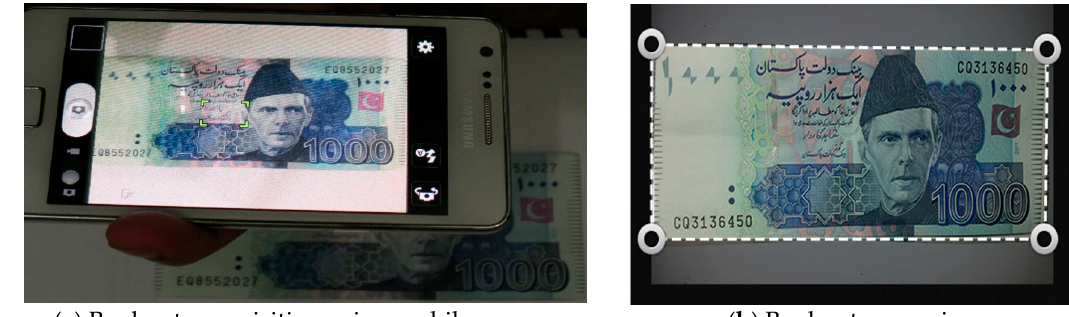
Figure 7. Banknote acquisition and cropping.